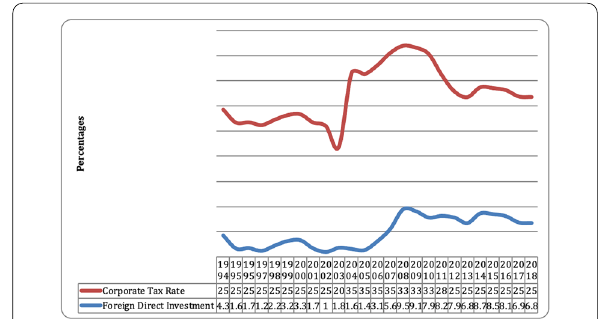
Fig. 2 FDIs and corporate rates in Ghana. Source UNCTAD 2018, World Tax Database